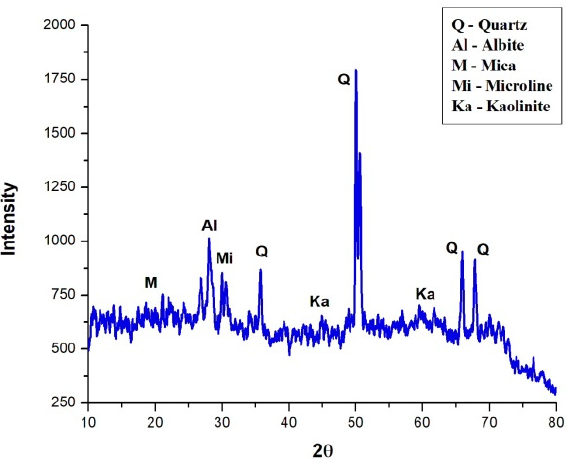
Figure 3. X-ray diffraction of granite powder.